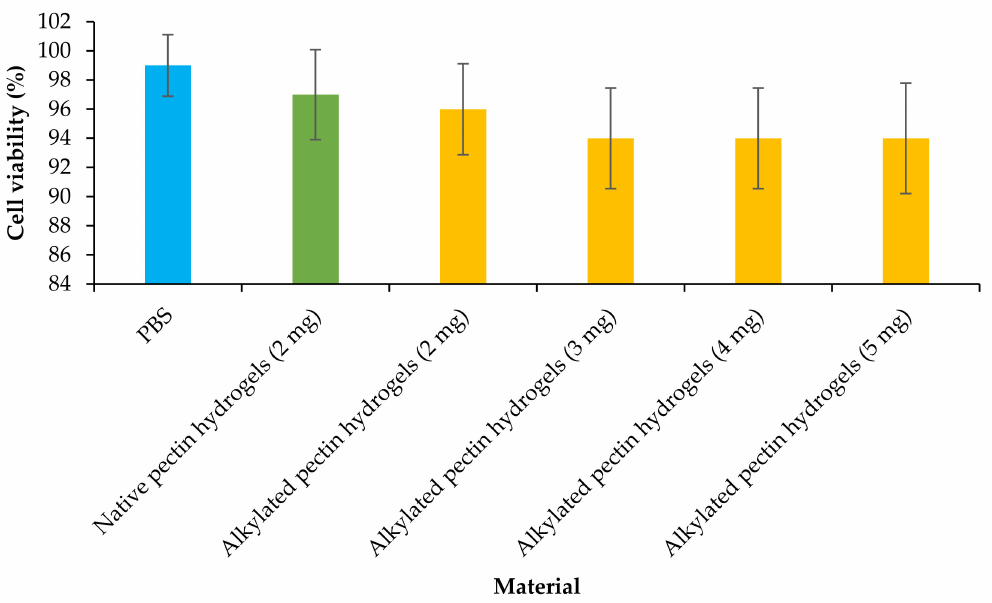
Figure 8. HaCaT cell viability analysis of pectin-based hydrogels ( n = 3; ±